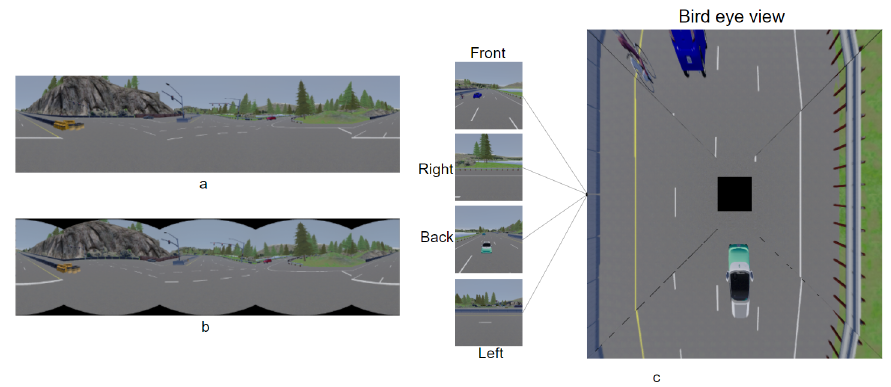
Figure 2. ( a – c ) Different input